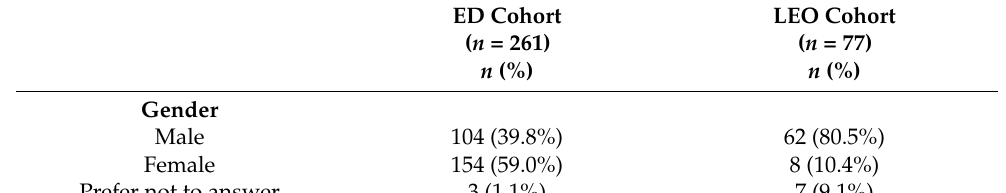
Table 2. Respondent Demographics.